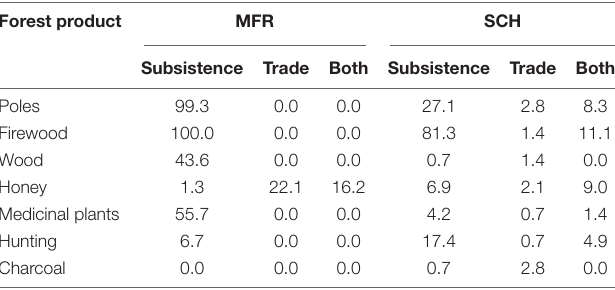
TABLE 6 | Commercialization of different products in MFR and SCH (number and percentage of households). Products